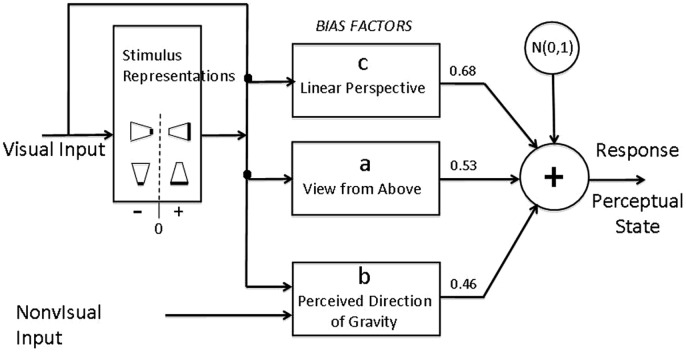
Block diagram representation of a quantitative model of the bias factors that determine the perceptual resolution of ambiguous oscillating trapezoids, i.e., whether the long side of the trapezoid is perceived to be closer or further from the observer. Visual input determines the possible stimulus representations (here indicated as trapezoids with the darkened edge as the edge represented as closer) and bias factors. A positive (negative) value for bias factor (A) is assigned to stimulus representations in which the long (short) edge has a lower position in head-centered coordinates; a positive (negative) value of (B) is assigned when the long (short) edge is lower in the physical world, i.e., in relative to gravity. Bias factor (C) is always positive and represents the perspective bias to perceive the long edge as closer than the short edge. N(0,1) represents Normally (Gaussian) distributed internal noise with mean zero and variance 1. When the sum of the bias factors and the sampled value of internal noise is positive on a given trial, the output response is a perceptual state (i.e., a particular one of the stimulus representations) in which the long edge is closer to the observer than the short edge, otherwise, the short edge is closer2.